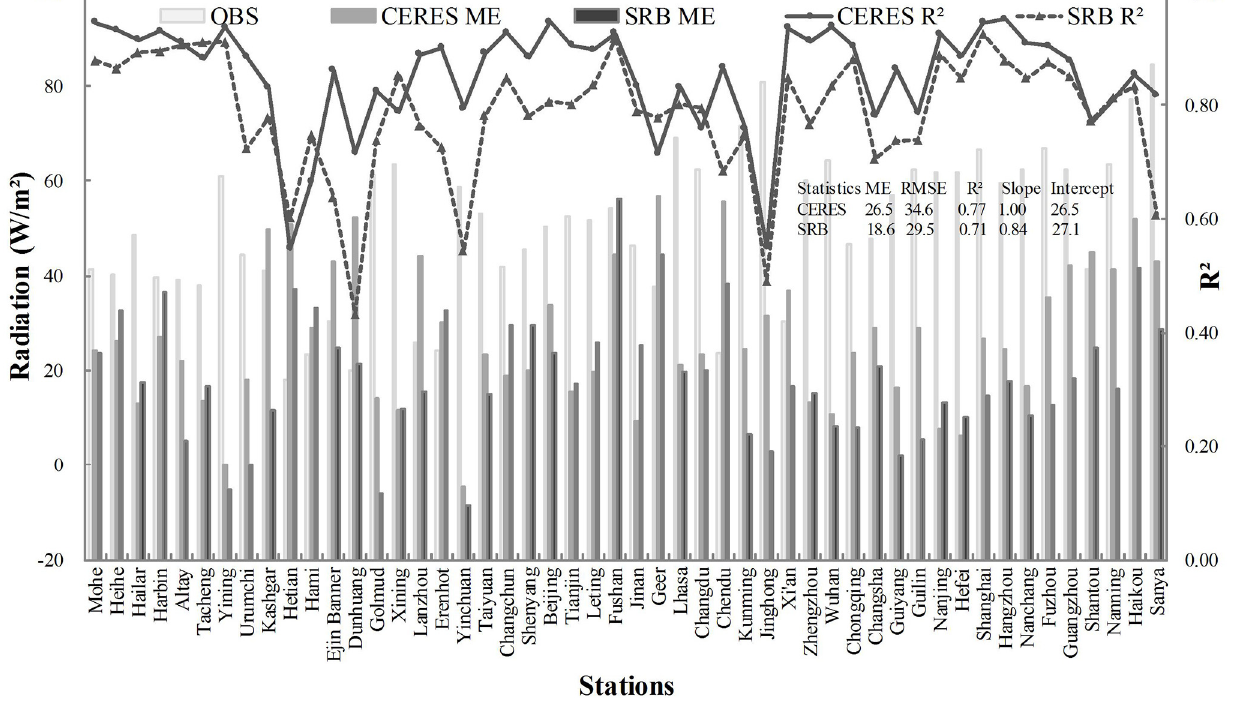
Figure 4. Statistical comparison of CERES, SRB, and observed (OBS) surface-measured monthly net